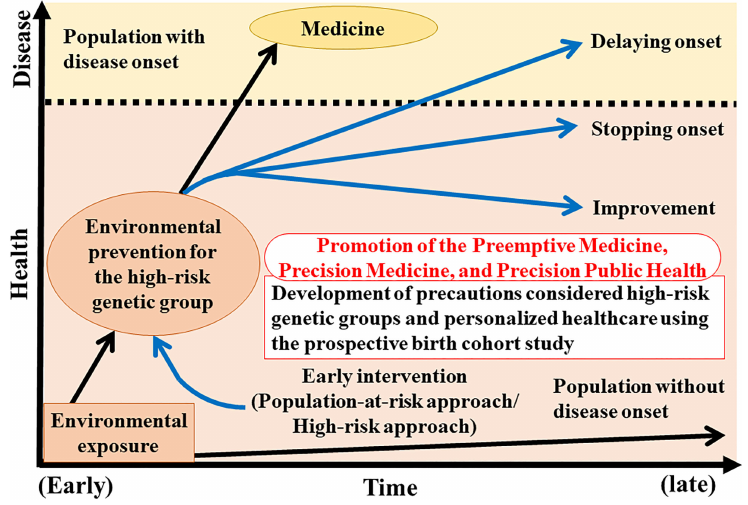
Fig. 2 Preventive medical application and promotion of gene-environment interaction